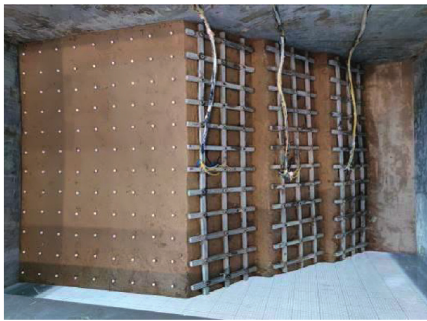
Figure 6: Arrangement of slope displacement monitoring